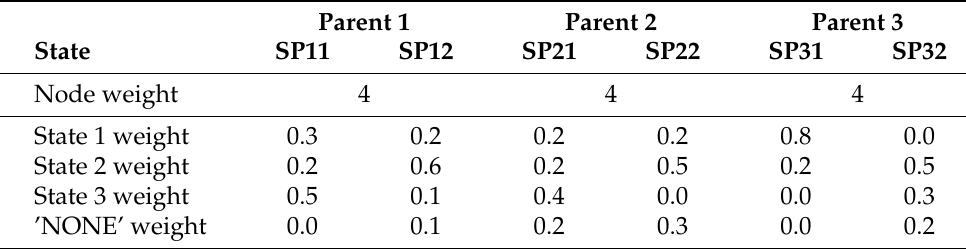
Table 3. Example CPT for each parent